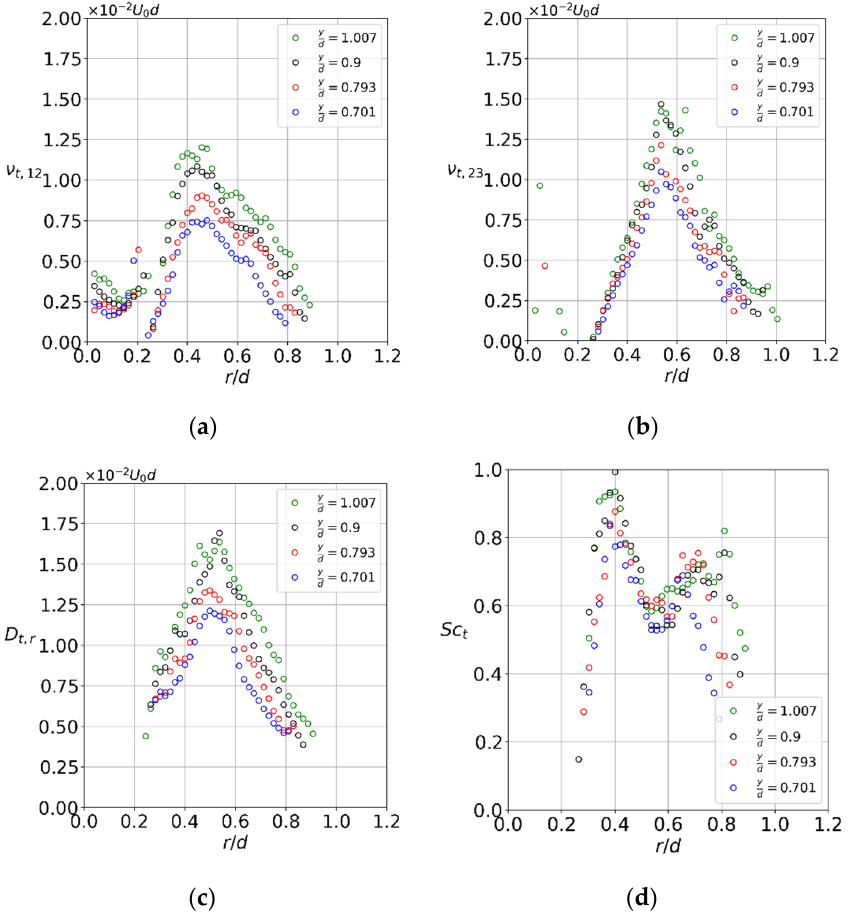
Figure 10. ( a , b ) Turbulent viscosity coefficients, ( c ) turbulent diffusion coefficient, and ( d ) turbulent Schmidt number for low-swirl jet.